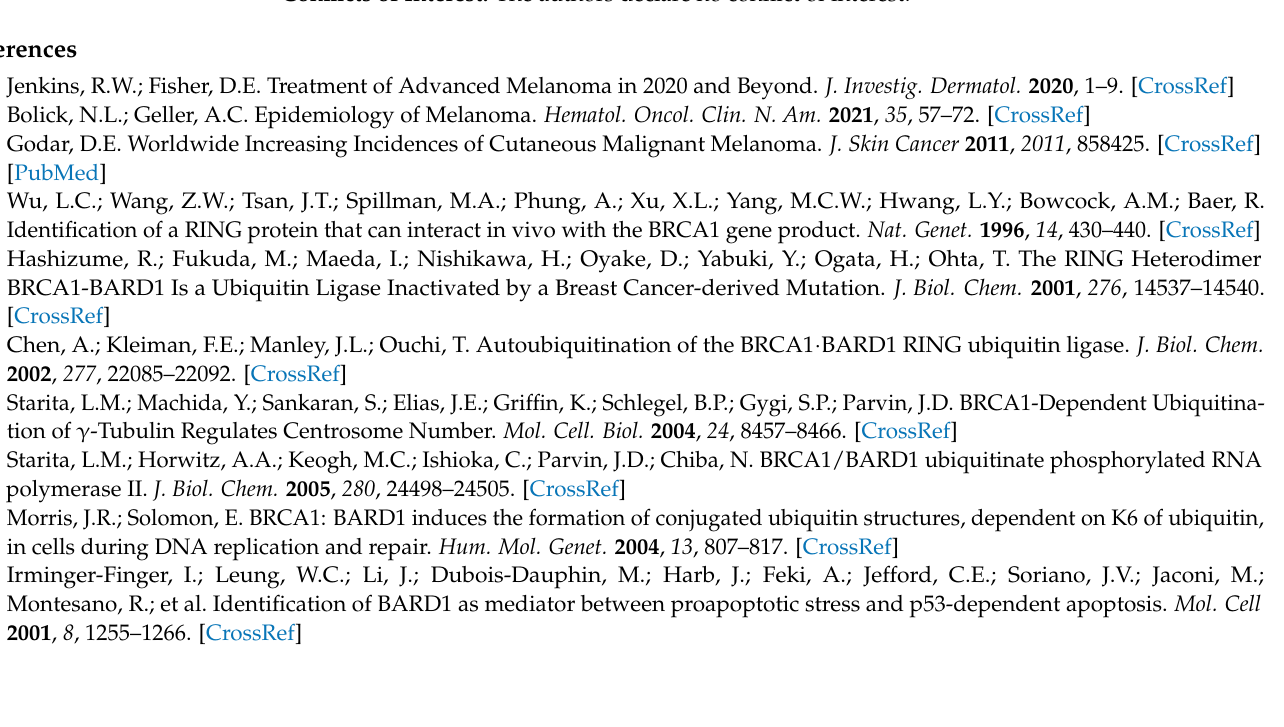
Table S2: Primer sequences used in the study, Table S3: BARD1 transcript variants identified using long-range Nanopore sequencing, Table S4: Expression of annotated BARD1 transcripts from RNA- Seq